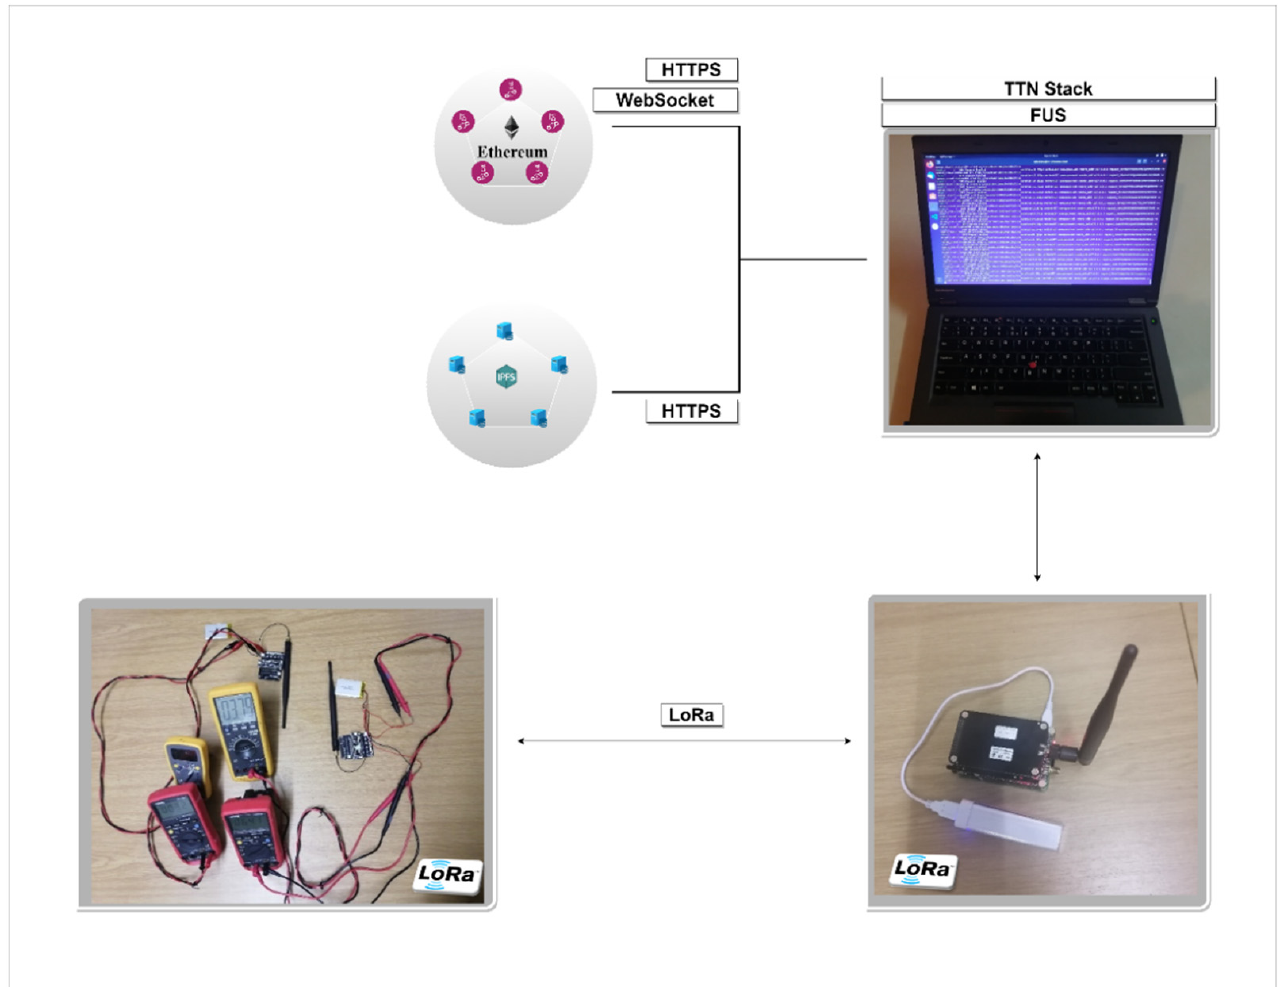
Figure 11. Experiment Architecture. Table 6. Development Environment and Libraries